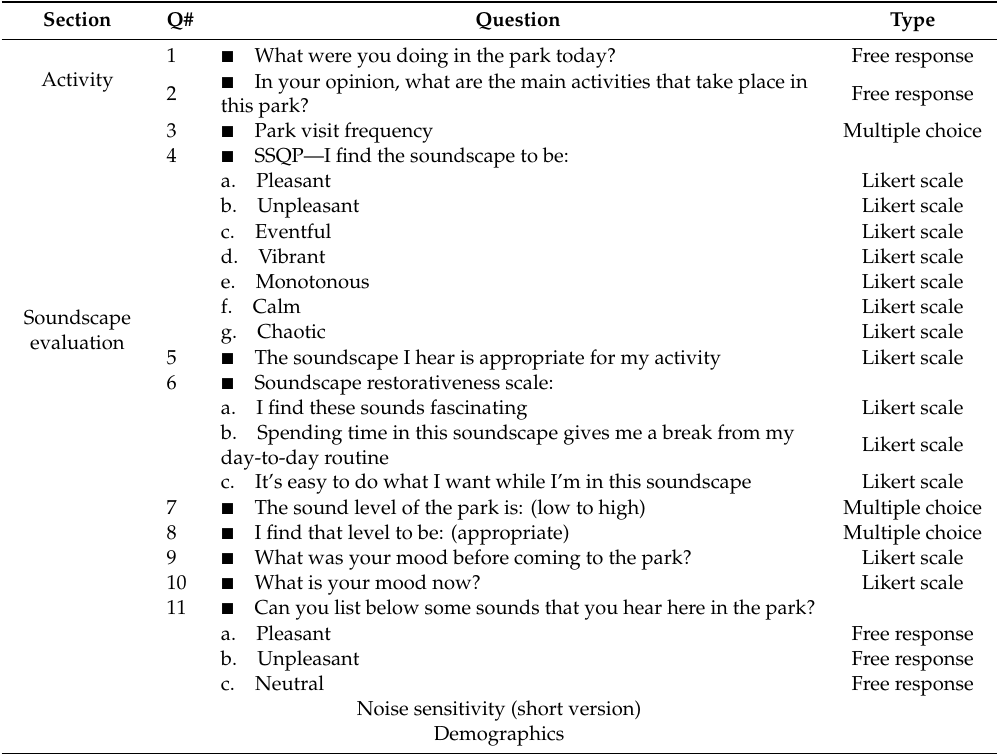
Table A1. Questionnaire Q1.